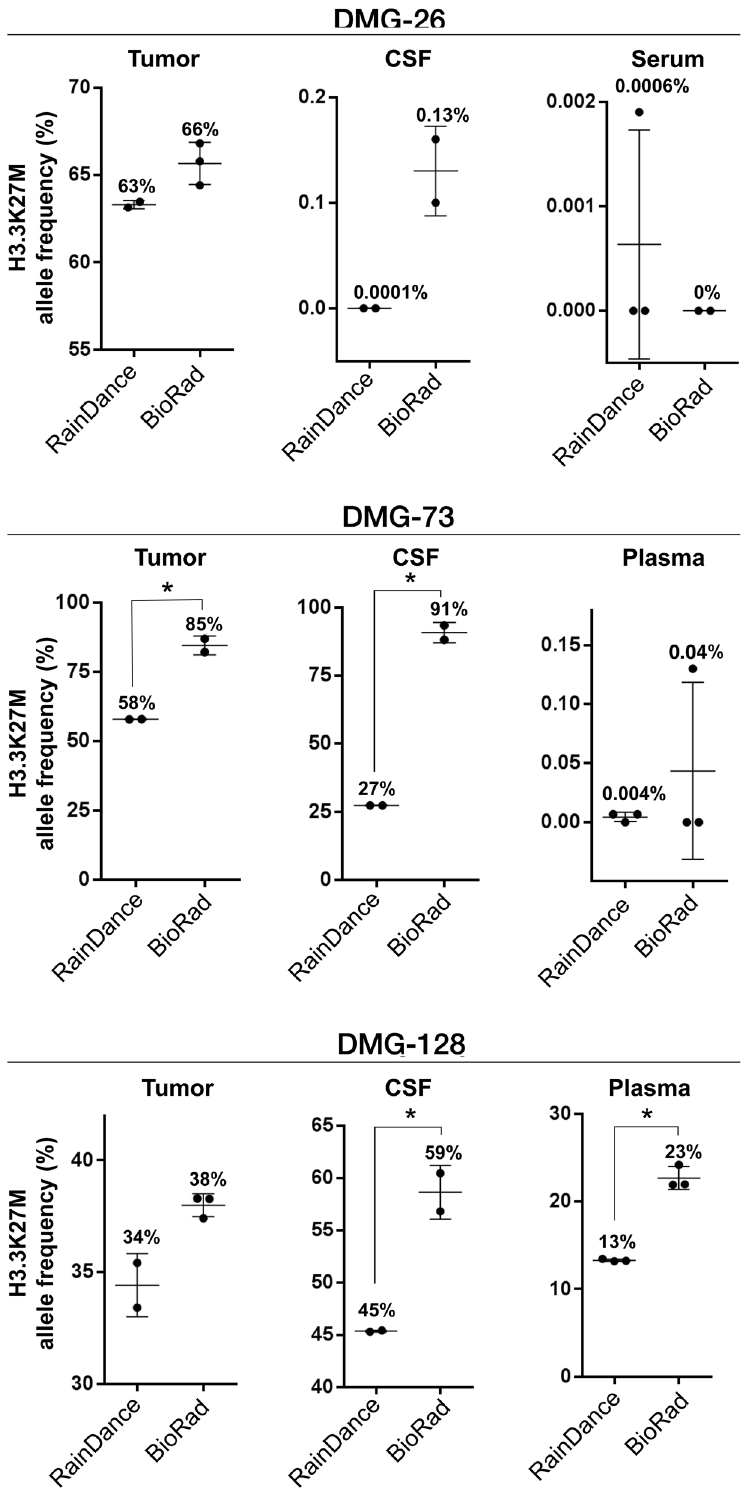
Figure 3. H3.3K27M mutant DNA is detectable in patient-matched tumor tissue, CSF and plasma or serum specimens. Patient-matched specimens from children with H3.3K27M mutant DMG (n = 3) were analyzed on the BioRad and RainDance platforms using Assay A. Mutant droplets were detected in all specimens across each subject tested, with greater MAF observed on the BioRad platform (t-test). Due to higher extracted [ctDNA] from DMG-128 CSF and plasma, samples were diluted 1:10 in DNA suspension buffer to prevent probe signal oversaturation. All other samples were diluted 1:5 as described. % values = Mutation Allelic Frequency (MAF); * = Statistically significant difference in MAF (t-test , p <